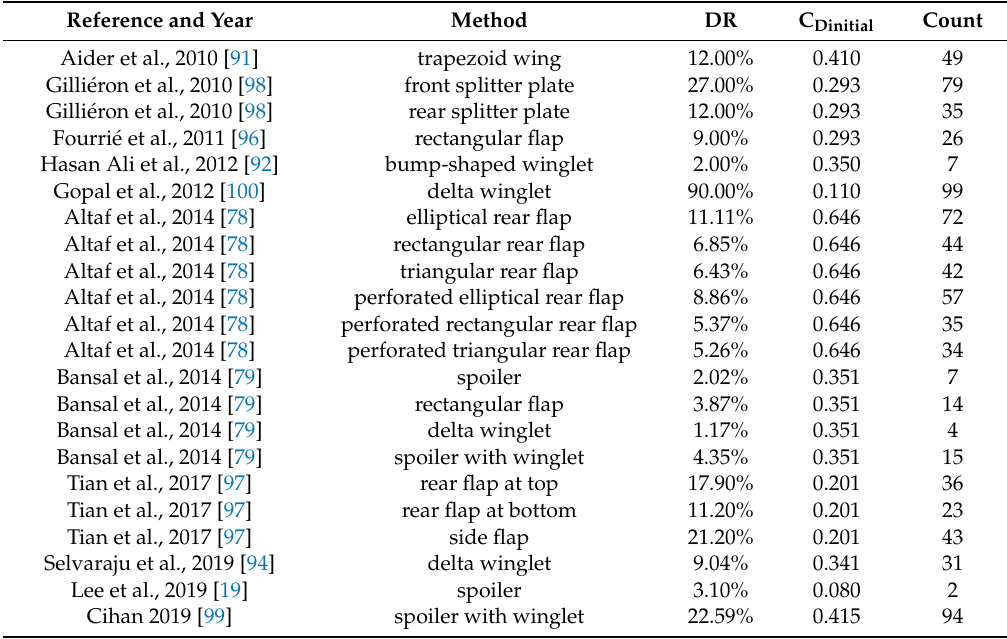
Table 3. Maximum DR by topology